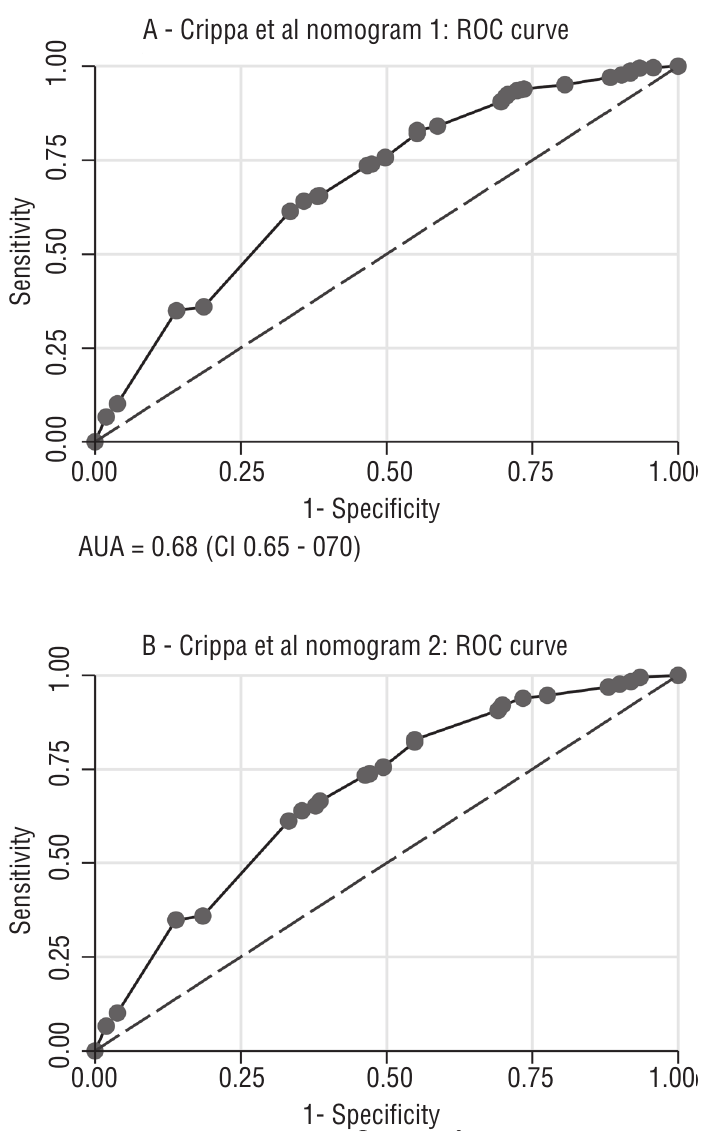
A - Crippa et al nomogram 1: ROC curve